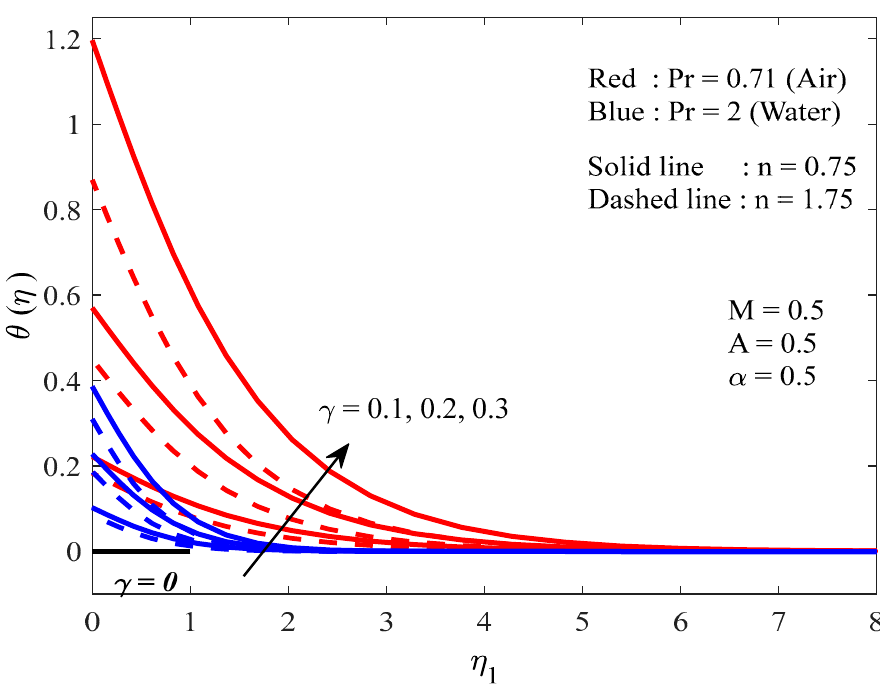
Figure 8. The temperature distribution profile for different values of γ & Pr